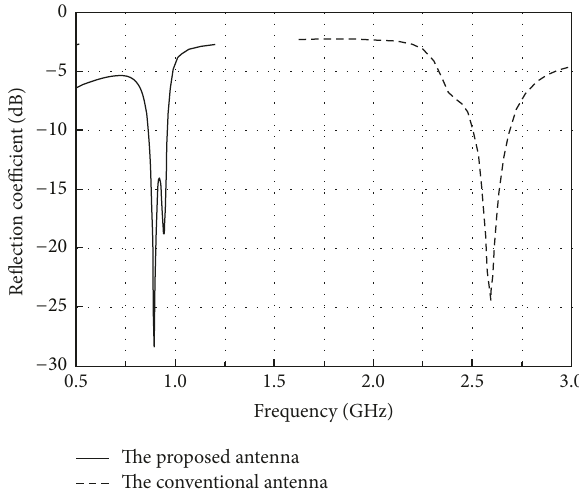
Figure 7: The comparison of the proposed antenna and the conven- tional antenna.